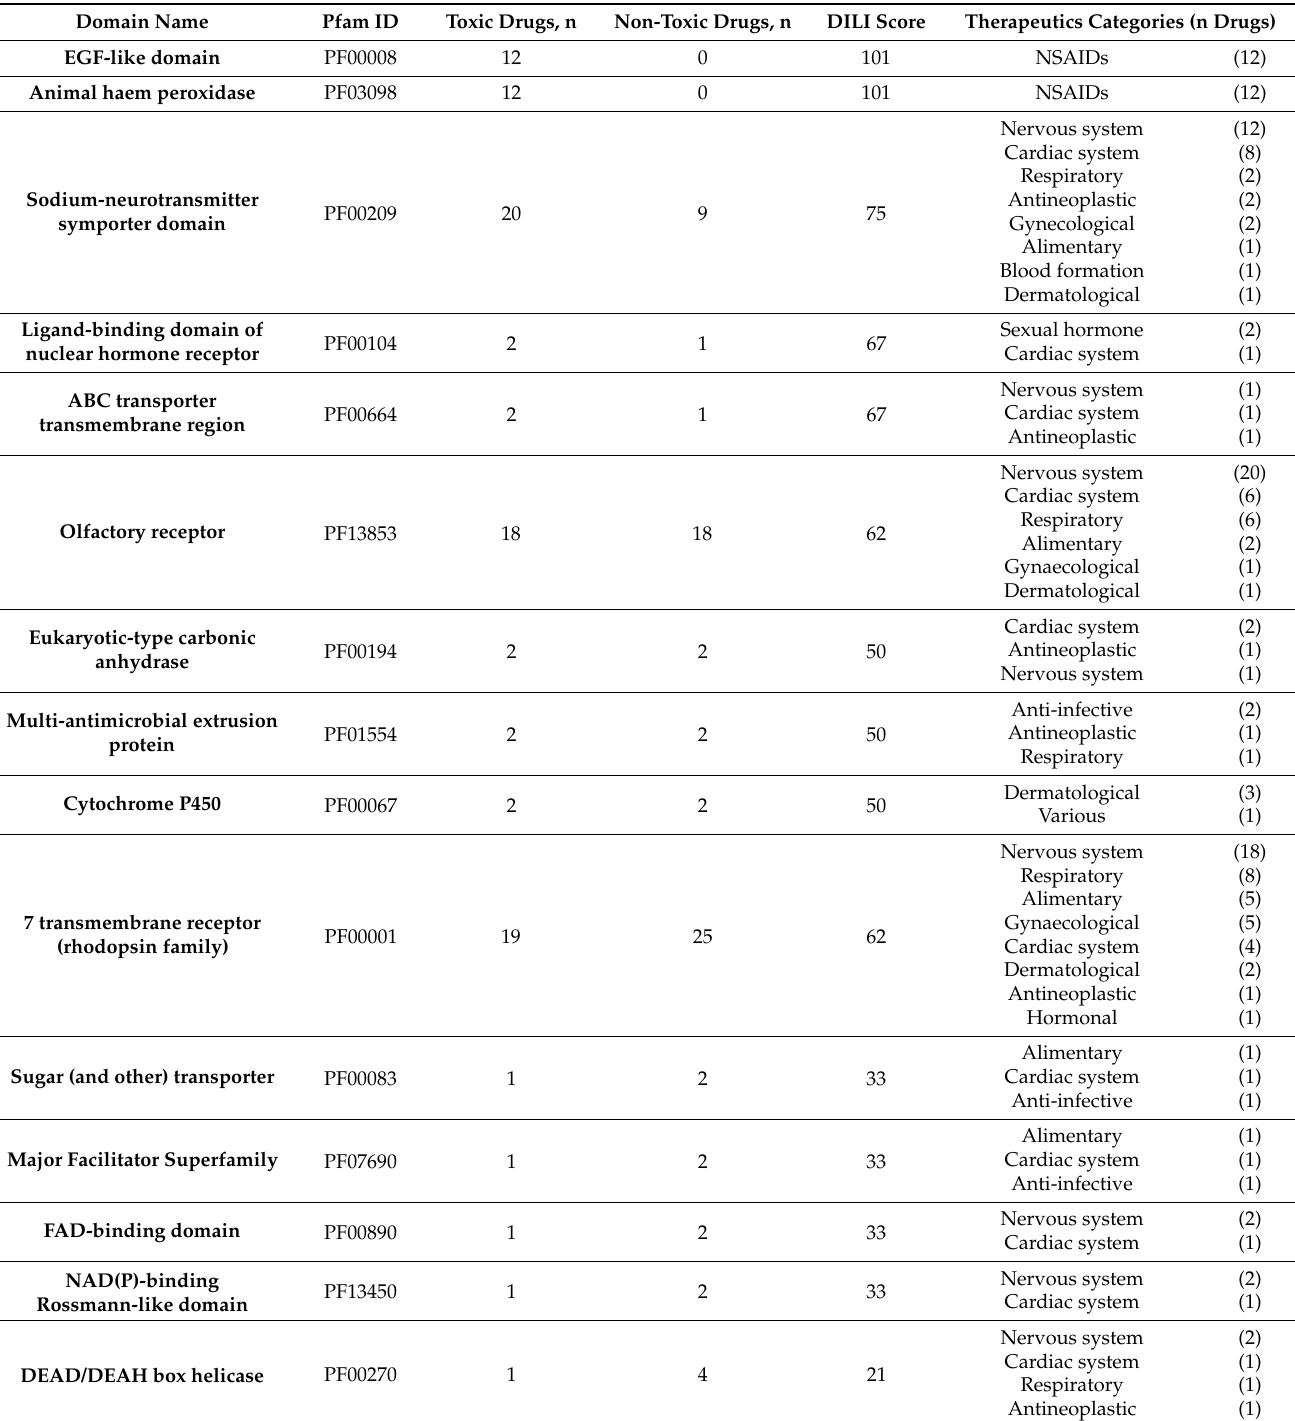
Table 1. Communities in the drug similarity